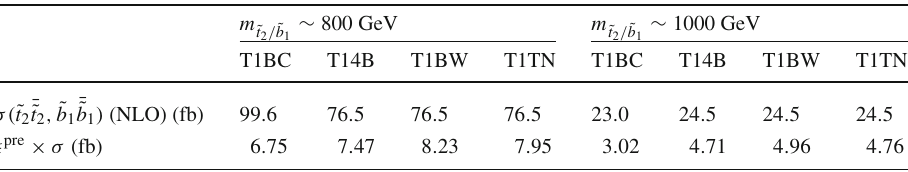
Table 2 Cross sections of benchmark points before and after preselections at 14TeV